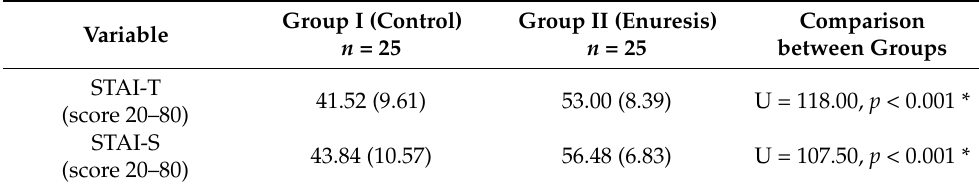
Table 3. Description of the mothers’ standardized STAI tests by